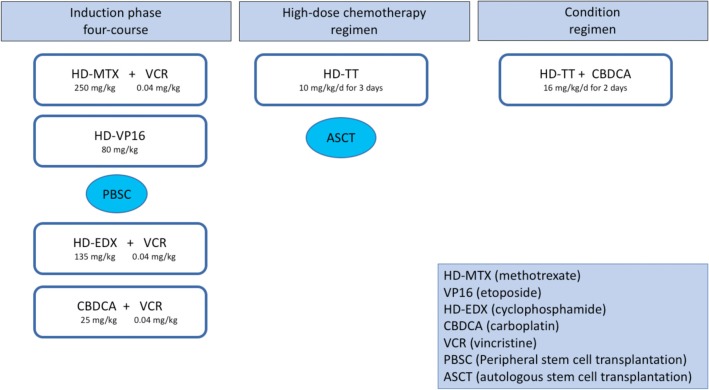
Treatment protocol.